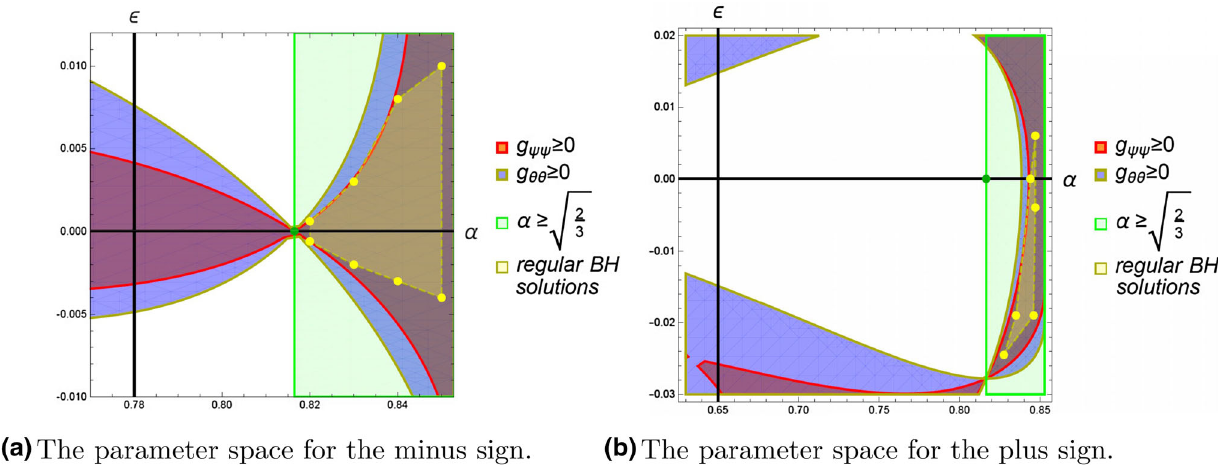
Fig. 1 On the left we show the parameter space with the minus sign choice in Eq. (3.19), while on the right we show the parameter space for the plus sign choice. We shaded in yellow the region where regular black hole solutions are